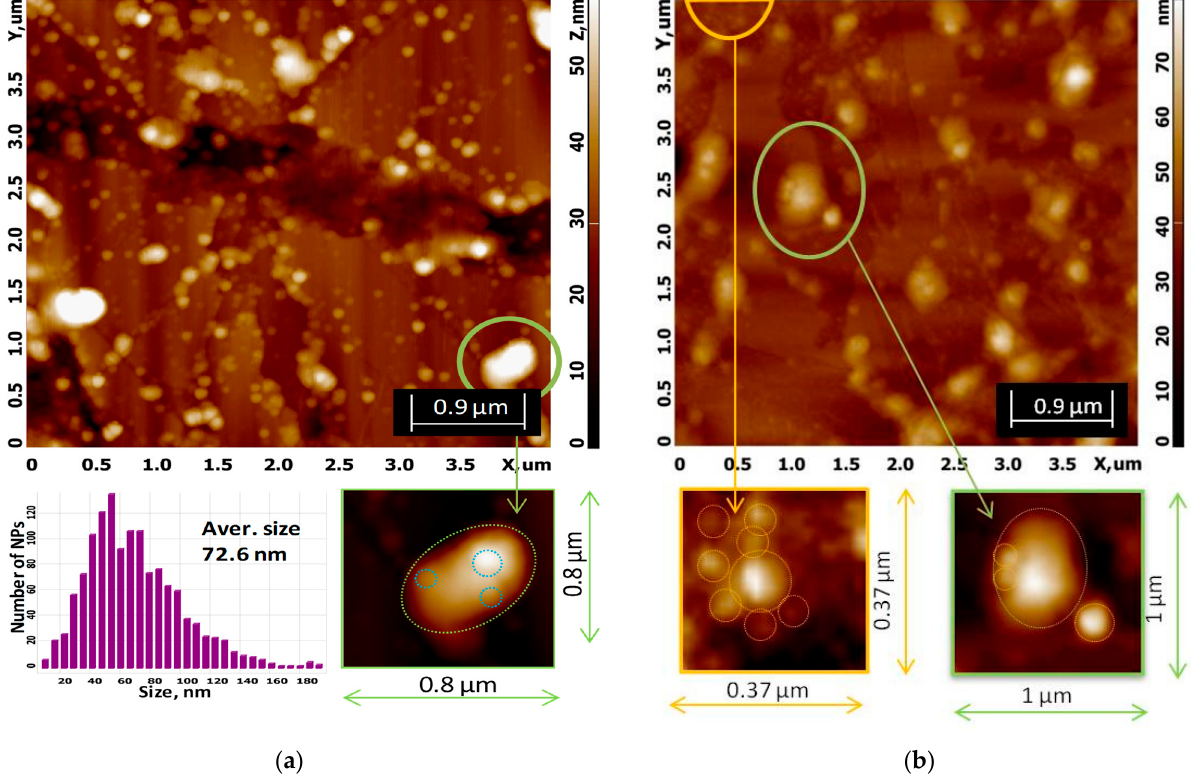
Figure 6. ( a ) AFM image of Ag/AgClNPs–Liposomes (P5—Biohybrid II) with the size distribution of the “free” silver/silver chloride nanoparticles. The cropped green fragment illustrates the association of Ag/AgClNPs with chlorophyll-a-labeled soybean lecithin liposomes. ( b ) AFM image of Ag/AgClNPs–Liposomes–CTS (P6—Biohybrid III); magnification of the areas with “free” Ag/AgClNPs and Ag/AgClNPs bonded to liposomes are presented in the cropped orange and green fragments,